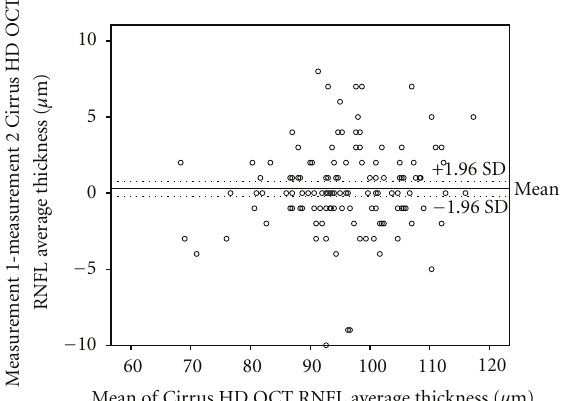
Figure 4: Bland-Altman plots of the agreement in retinal nerve fiber layer (RNFL) thickness between Stratus OCT and Cirrus HD OCT. The di ff erence (Stratus OCT average RNFL thickness minus Cirrus HD OCT average RNFL thickness) was plotted against the average of the three measurements for the average RNFL thickness Cirrus HD OCT measurements. SD: standard